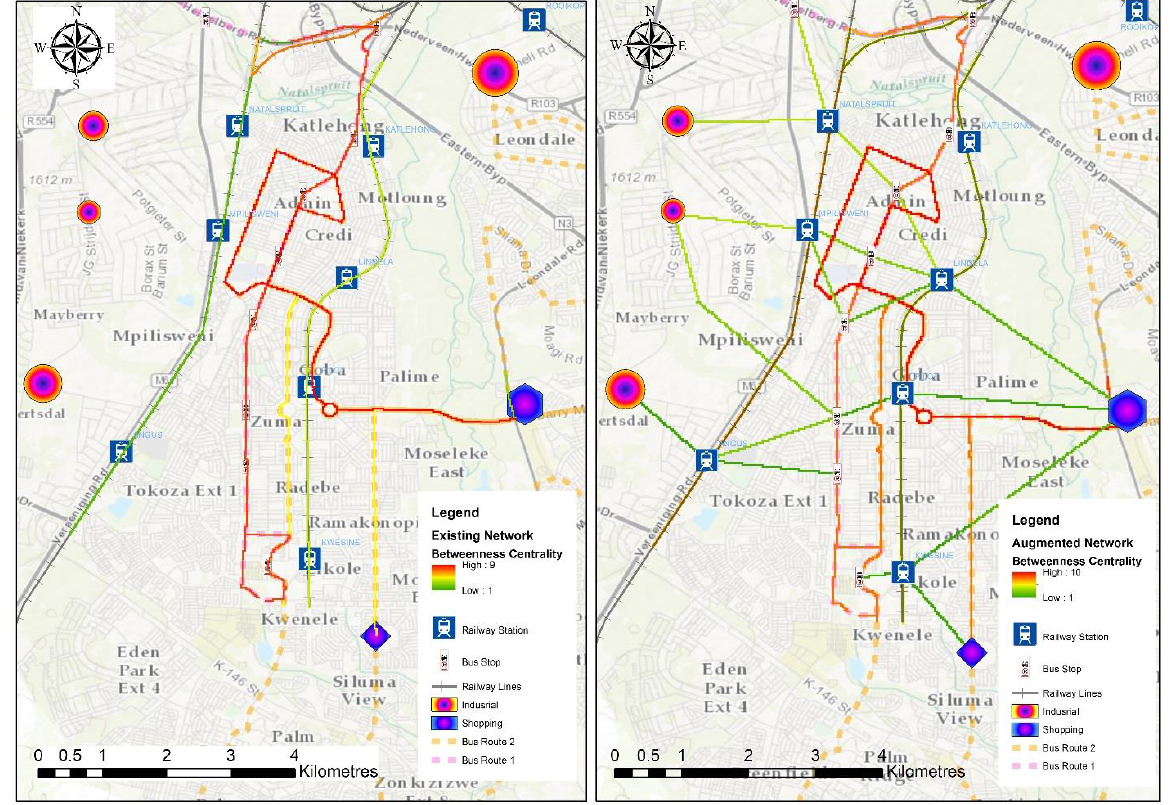
Figure 3: Betweenness Centrality of Existing Network and Augmented Network Generally nodes with high betweenness centrality allow the flow of commuters between every pair of bus/train stops, over the shortest paths between them. For the existing network, currently nodes along the Bus Route have the highest betweenness centrality. This could be due to the service quality of the Bus rapid transit system, as most commuters utilise the bus to travel in-between the townships and utilise the Metro-rail for longer